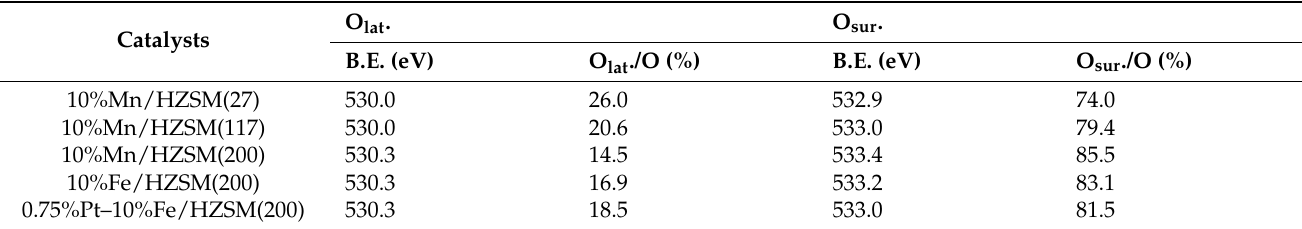
Table 3. Binding energy and proportion of each O species.